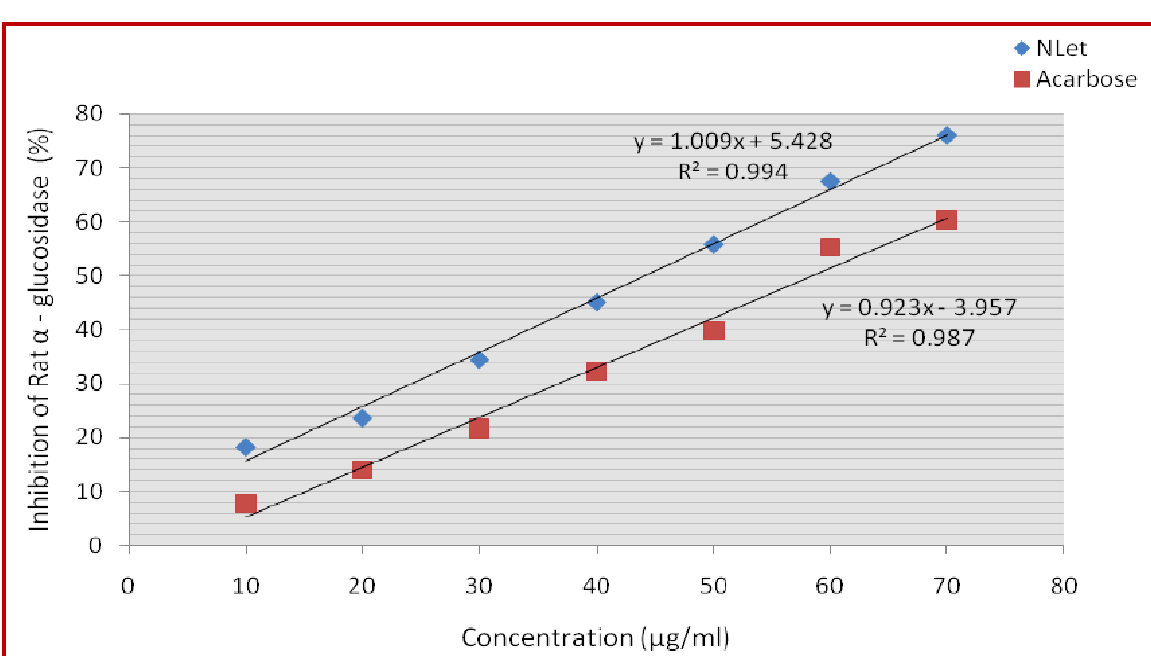
Figure 2: Inhibitory effect of N. laevis extract on rat intestinal α - glucosidase Values represent mean ± SEM of three